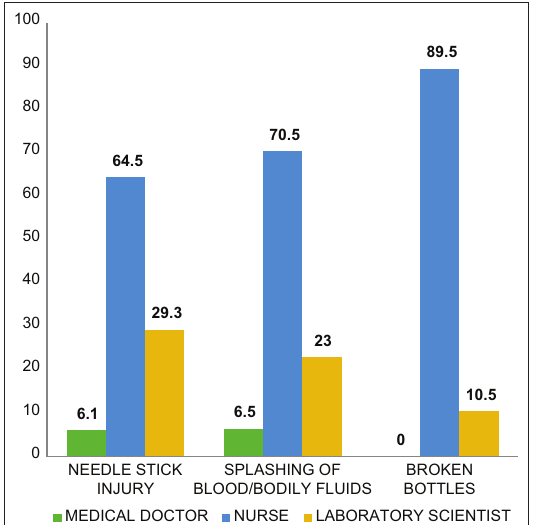
Figure 2 : Prevalence of Occupational Injury Types Per the Participant’s Specialty